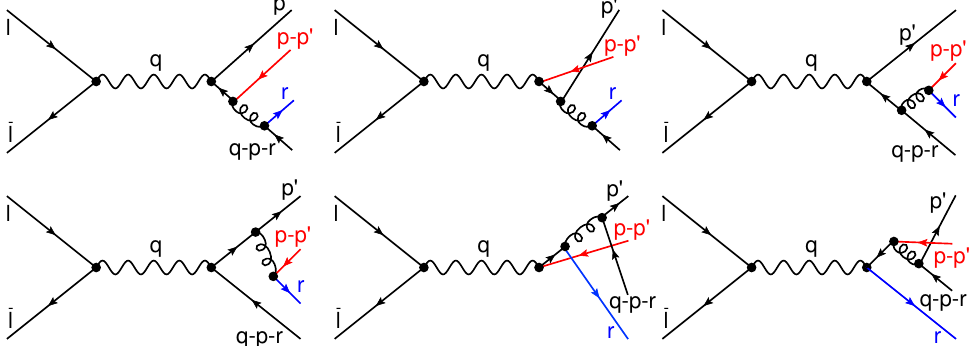
Figure 9. NLO corrections from quark radiation to quark/anti-quark fragmentation.